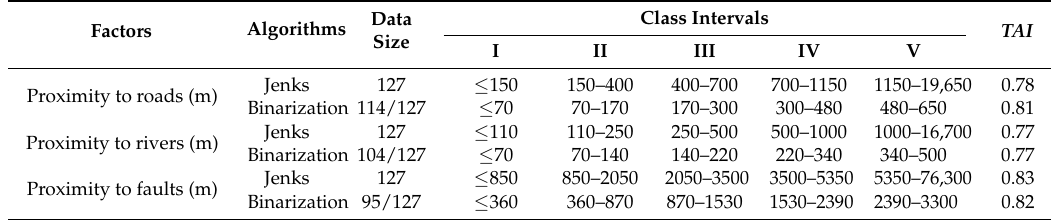
Table 4. Classification of locational